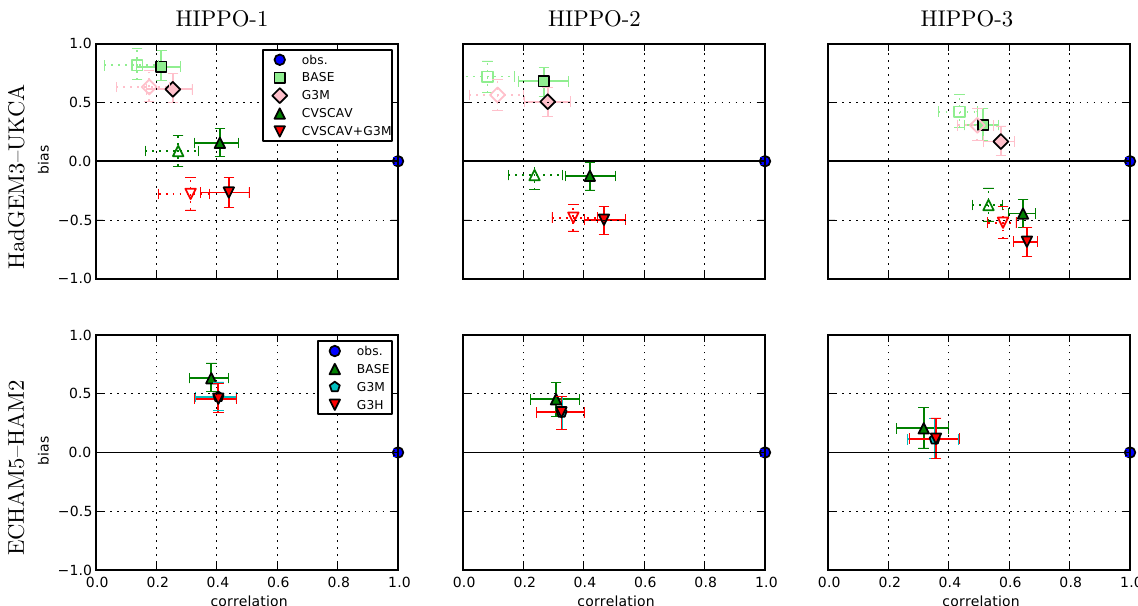
Fig. 5. Bias-correlation plots of log(BC mass mixing ratio) between the HadGEM3–UKCA (top row) and ECHAM5–HAM2 (bottom row) simulations and each phase of the HIPPO campaign (columns). The error bars represent a 95% confidence interval based on a moving-block bootstrap and the ± 30% error in the SP2-derived mixing ratios from HIPPO-1. The solid symbols represent nudged simulations, while the hollow symbols (for HadGEM3–UKCA) represent free-running simulations. The “obs.” point on the right-hand side indicates where a model which reproduces the observations perfectly would be